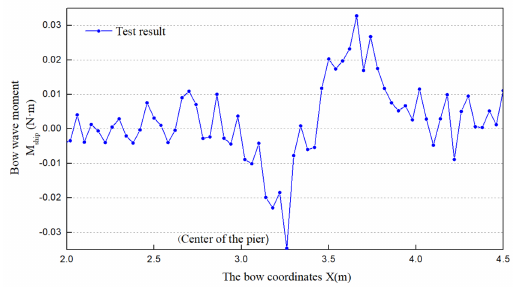
Figure 14. Change rule of bow roll